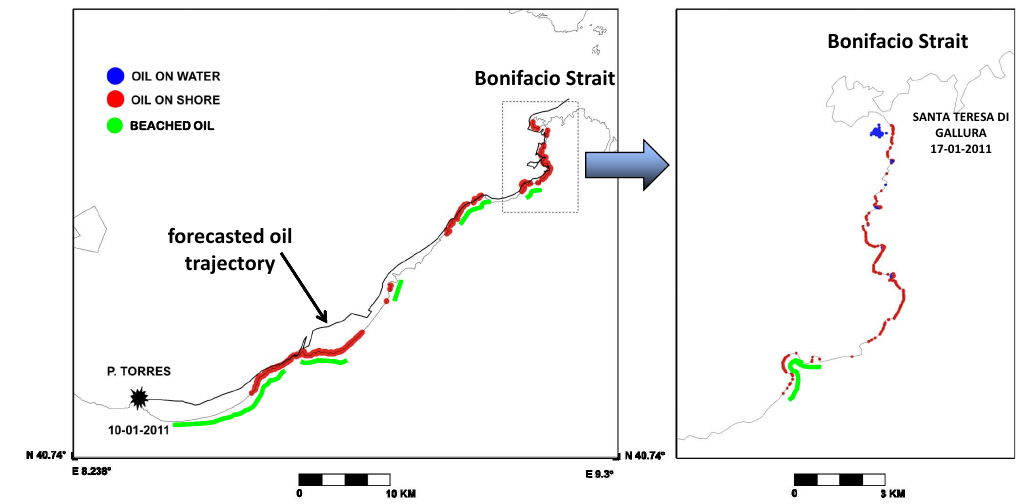
Figure 5 Fig. 5. Map of the area where the accident of Porto Torres occurred in January 2011 and the hindcast simulation results. Red lines indicate tracts of coastal area impacted by the simulated oil; green lines the sampled beached oil. The blue circle indicates where the oil at sea was detected by airborne surveys close to the entrance of the Bonifacio Strait. In the left panel the black line indicates the average trajectory followed by the particles on water. In the right panel a snapshot of model results at the 12:00 a.m. of 17 January 2011.